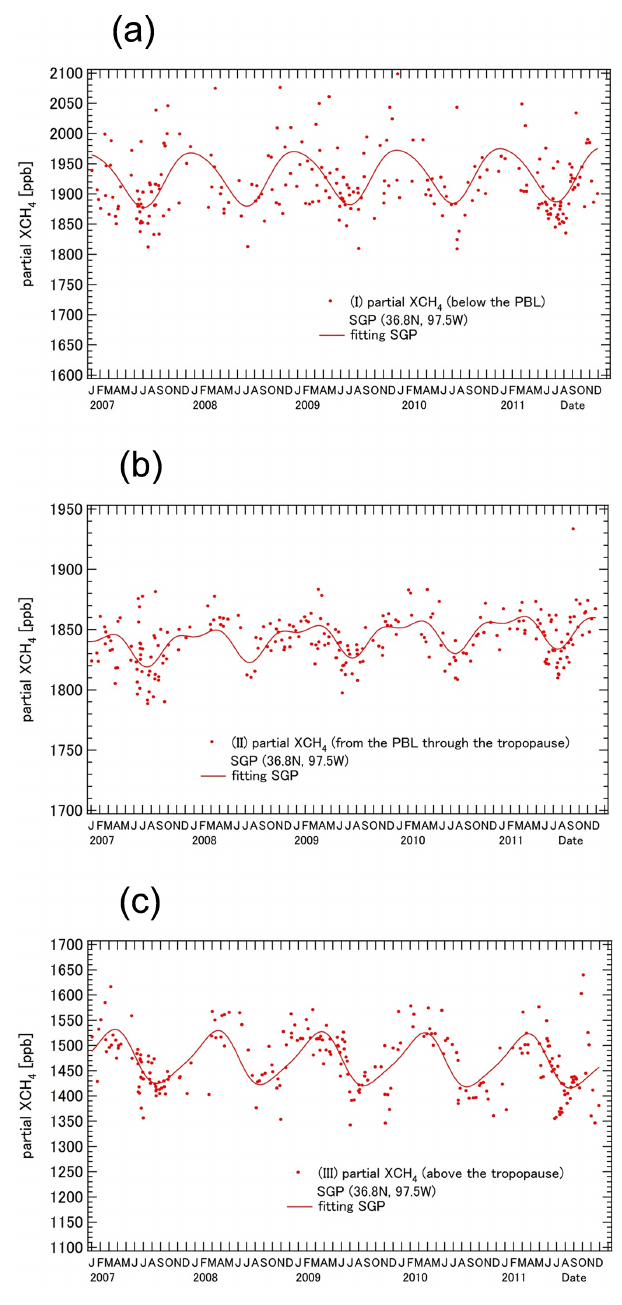
Figure 4. Temporal variations of partial XCH 4 over the South- ern Great Plains (SGP), calculated (a) below the PBL (domain I), (b) from the PBL to the tropopause (domain II), and (c) above the tropopause (domain III). The dots represent partial XCH 4 data, and the lines are fitted curves. See text for more